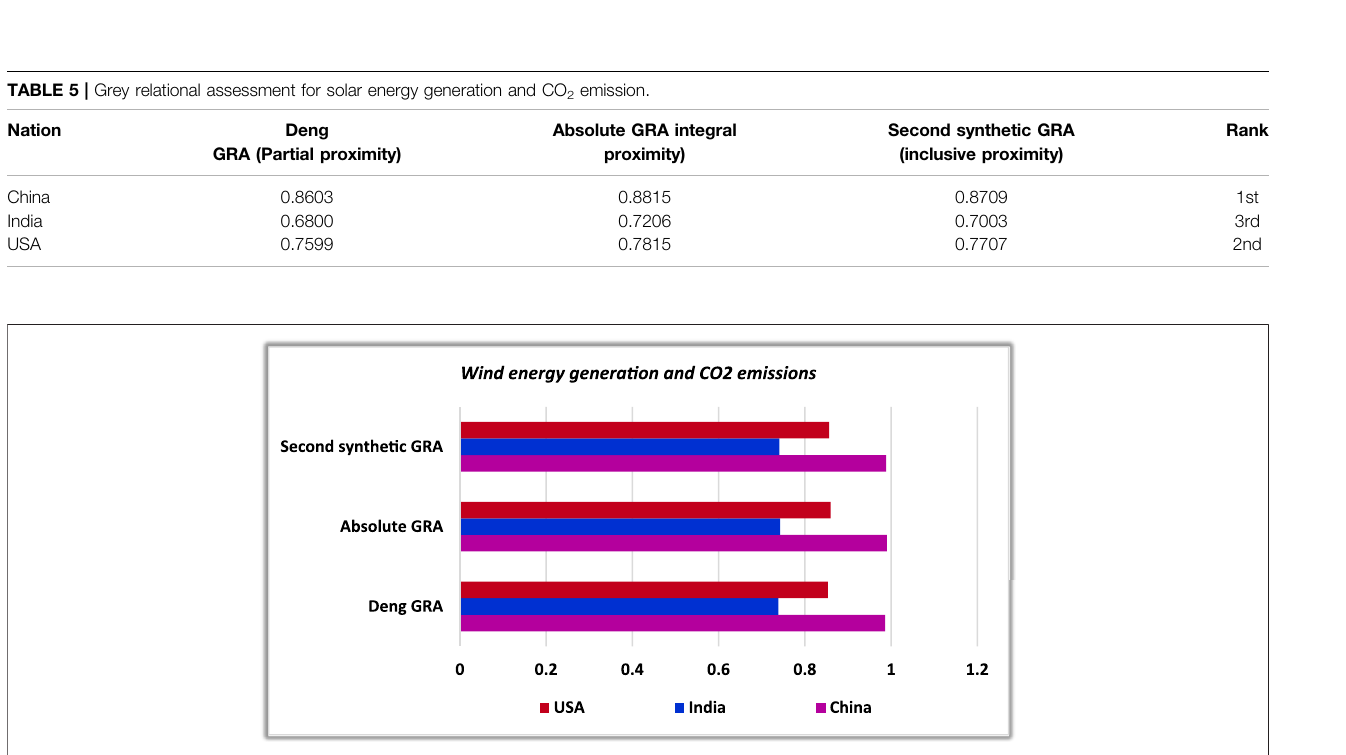
FIGURE 4 | Grey relational assessment between wind energy generation and CO 2 emissions.